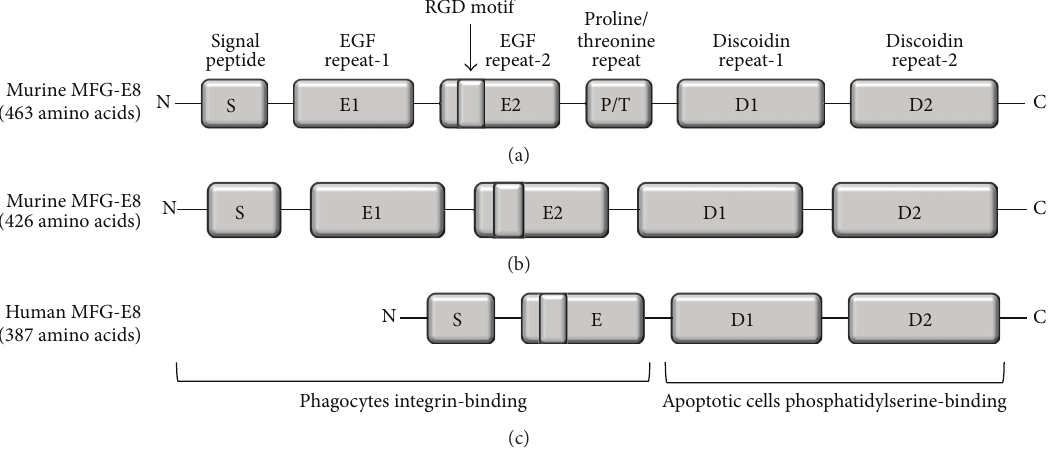
Figure 1: Structures of the (a) long form and (b) short form of murine MFG-E8 and (c) human